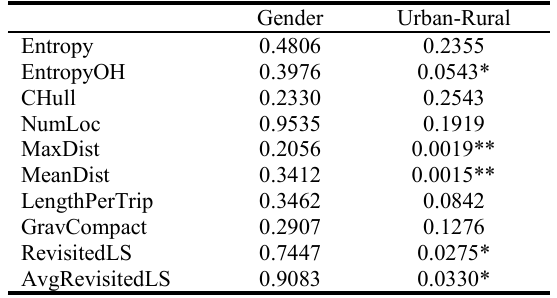
Table 2. The results of the Mann-Whitney U test for the